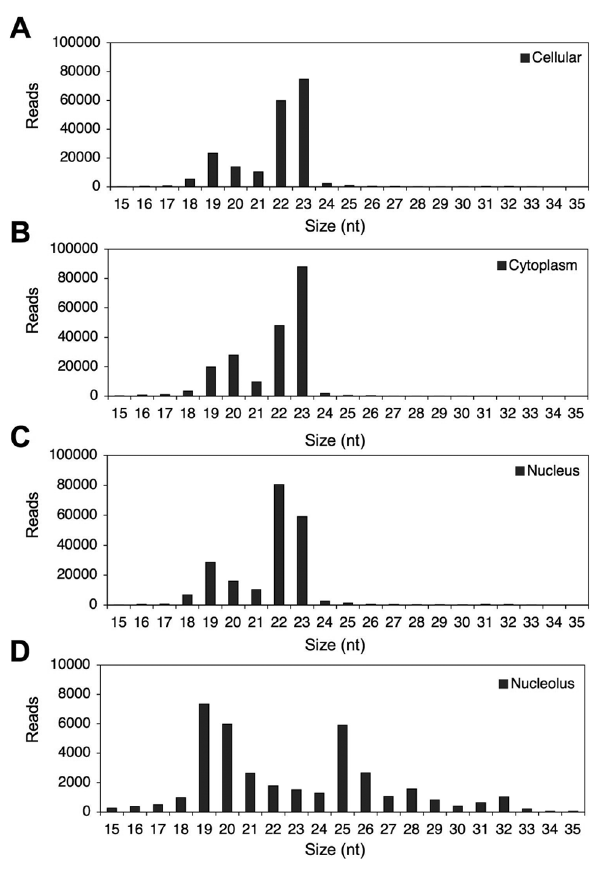
Figure 2. Size-distribution of the annotated small RNA sequence reads in the subcellular compartments. A Cellular RNA reads. B Cytoplasmic RNA reads. C Nuclear RNA reads. D Nucleolar RNA reads.